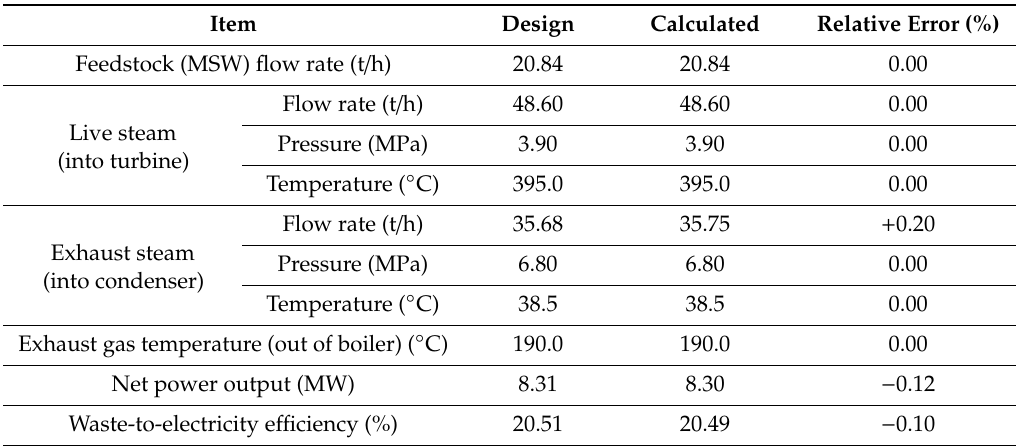
Table 6. Comparison of the simulation results and design data of the reference WtE plant. Item